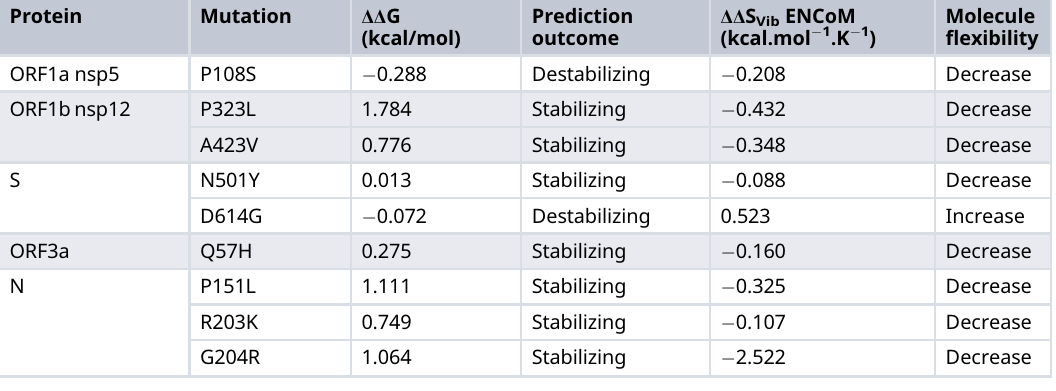
Table 4. Prediction of nonsynonymous mutation effect on SARS-CoV-2 proteins stability.